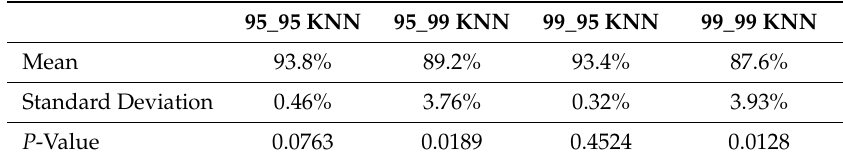
Table 12. Mean, standard deviation, and p -value for Anderson Darling test, for the KNN models tested against cleaned